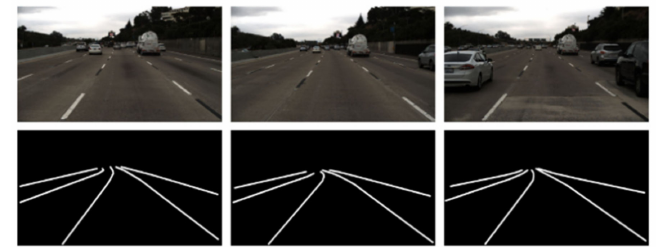
Figure 1. Continuous